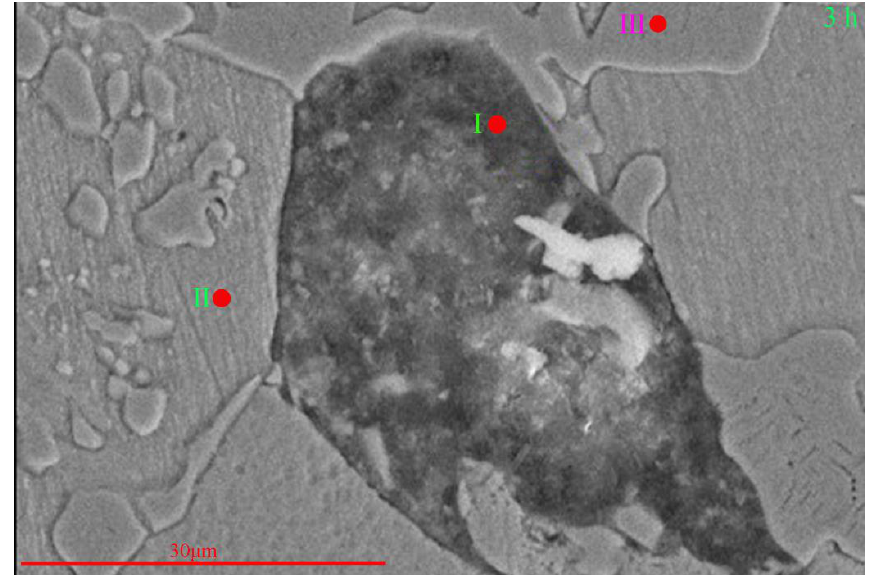
Figure 11. SEM image of S-Defect immersed in artificial seawater for 3 h. Table 6. The composition of S-Defect immersed in artificial seawater for 3 h.